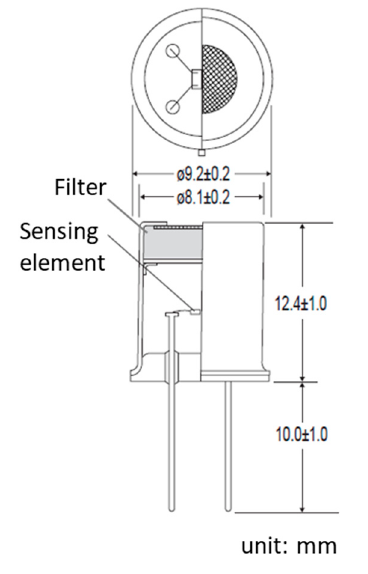
Figure 1. Structure and dimensions of TGS2630.